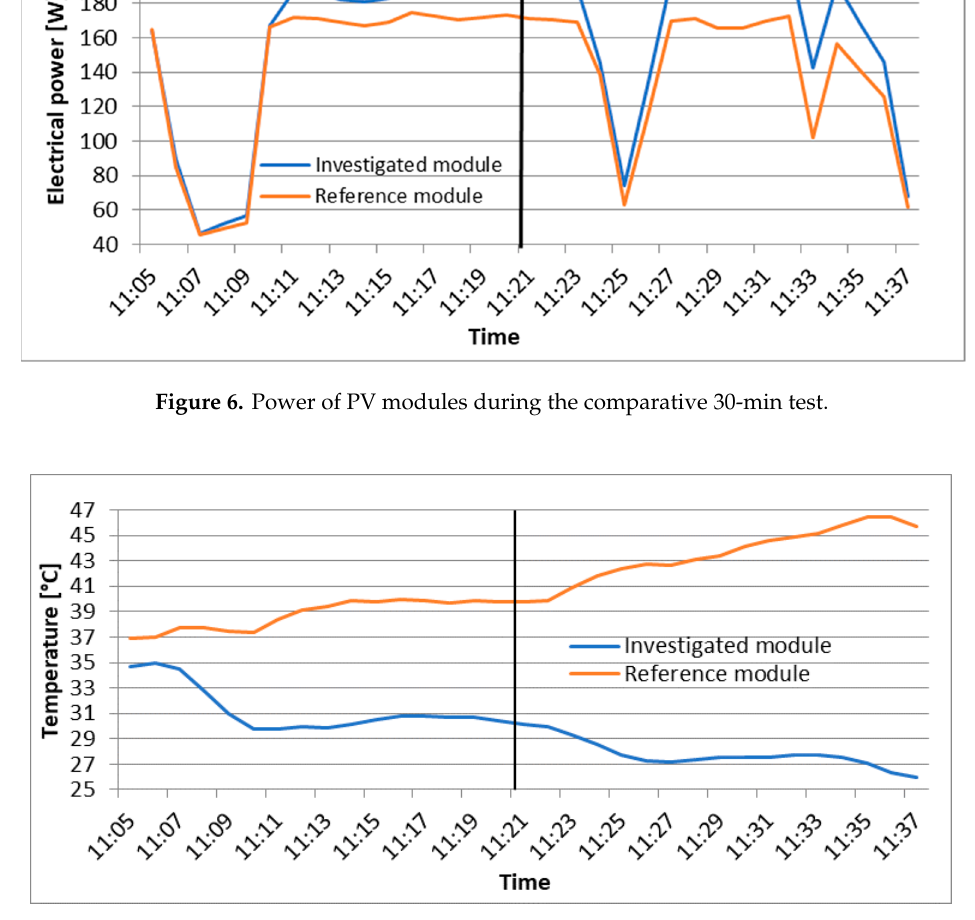
Figure 7. Temperatures of investigated and reference modules during the comparative 30-min test.